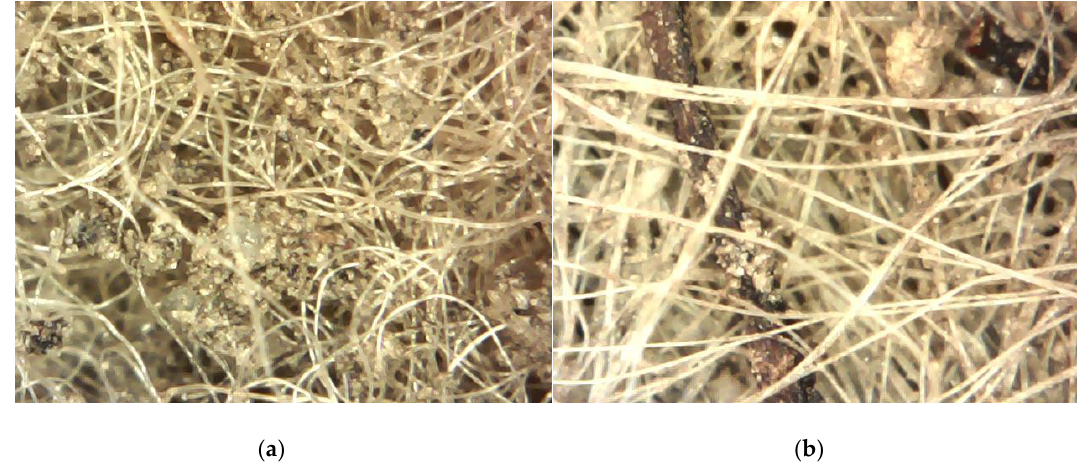
Figure 2. Geotextile materials after 24 months of testing under natural conditions: ( a ) colmatage after testing; ( b ) penetration of plant roots after testing.